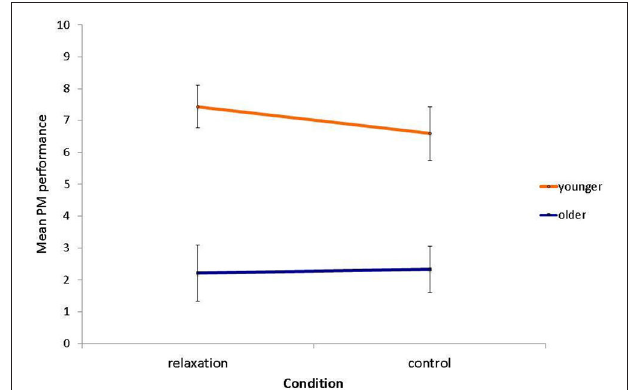
FIGURE 3 | Mean PM performance as a function of relaxation condition and age (max. possible PM hits = 10). Bars represent standard